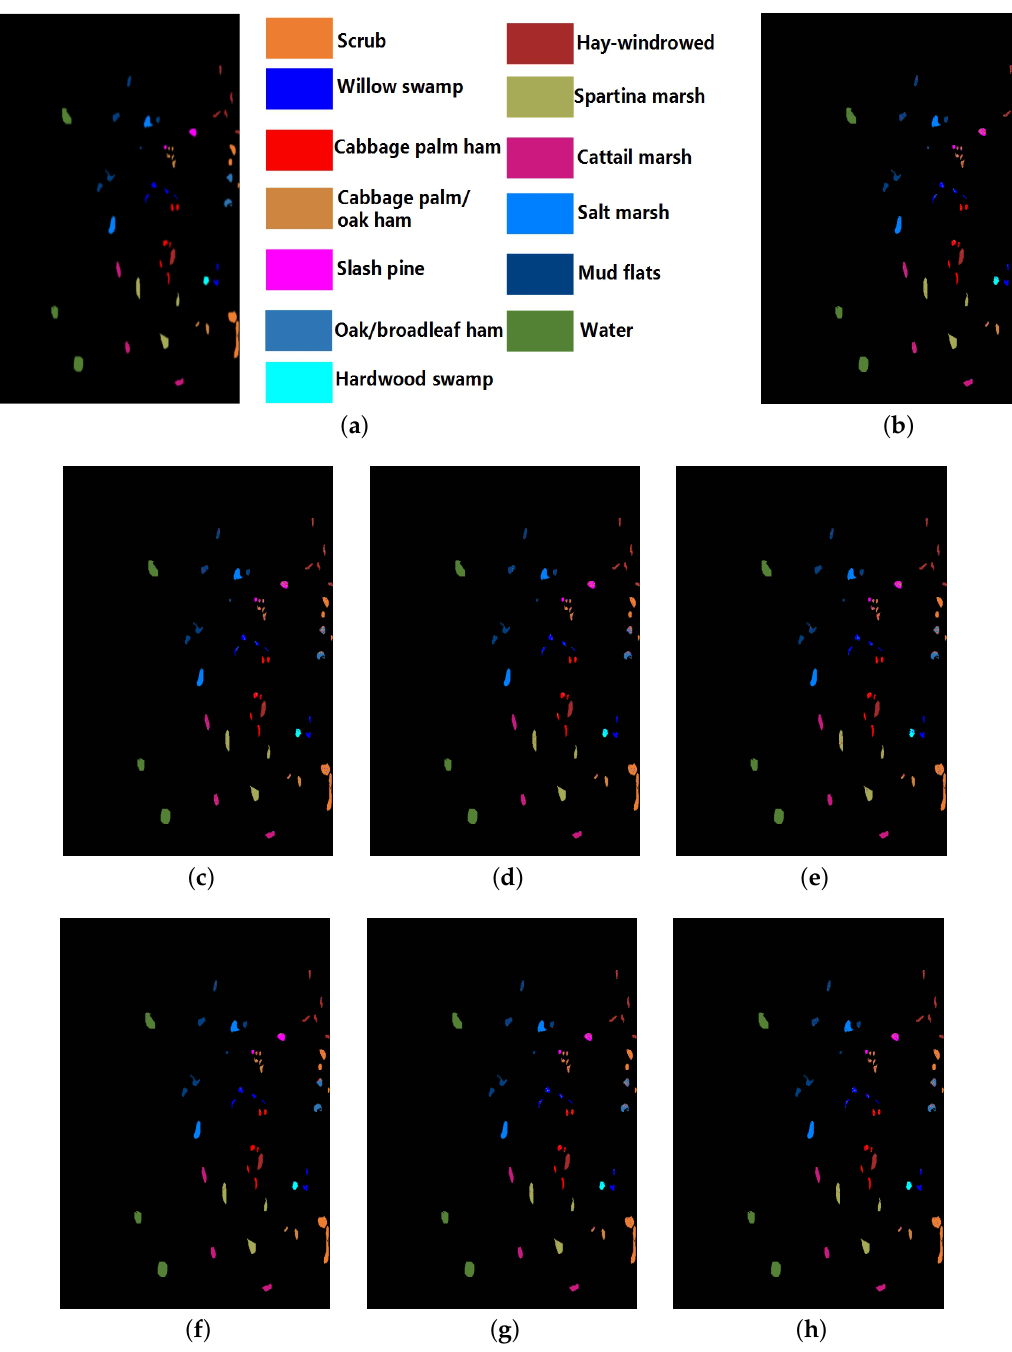
Figure 4. Ground truth (GT) and classification maps of SVM, RF, RoF, CNN, SMOTE-RoF, RBDF as well as the proposed SMOTE-WDRoF method on the hyperspectral data KSC . ( a ) GT. ( b ) SVM. ( c ) RF. ( d ) RoF. ( e ) SMOTE-RoF. ( f ) CNN. ( g ) RBDF. ( h )